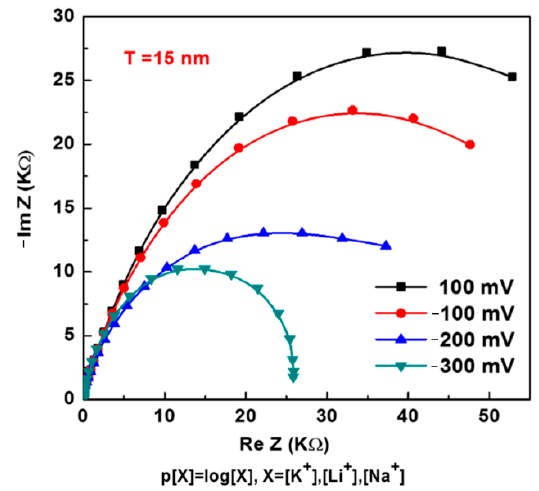
Figure 7. Impedance spectra (in Nyquist presentation) of the HfO 2 structures for different polari- zations vs. saturated calomel reference electrode (SCE). Electrochemical impedance spectroscopy (EIS) measurements were carried out in 0.4 mol·L − 1 Mg (NO 3 ) 2 prepared in TRIS buffer using the following conditions: frequency range from 100 mHz to 100 kHz, AC amplitude voltage at 25 mV.